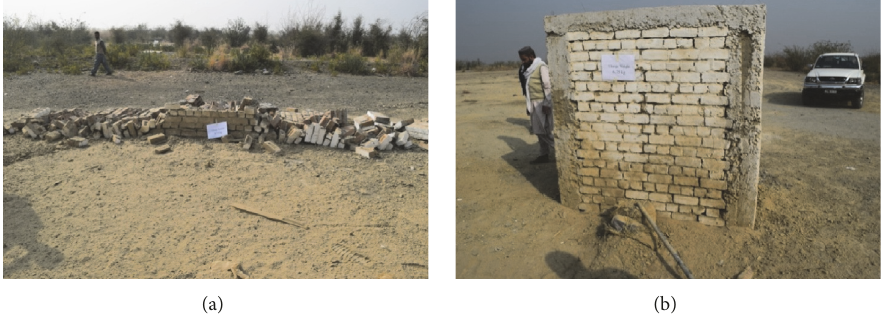
Figure 8: For scaled distance 1.89 m/kg 1/3 postblast scenario, (a) unreinforced masonry and (b) confined